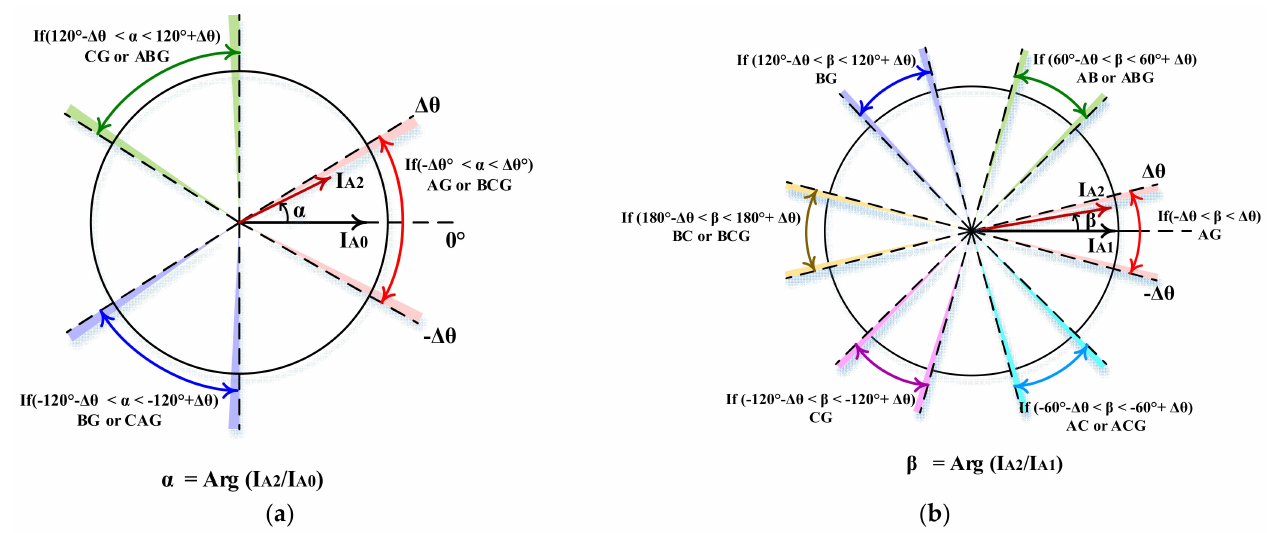
Figure 1. ( a ) Angle difference between ‘Phase A’ negative and zero sequence current phasors during bolted faults (i.e., α ), ( b ) Angle difference between ‘Phase A’ negative and positive sequence current phasors during bolted faults (i.e., β